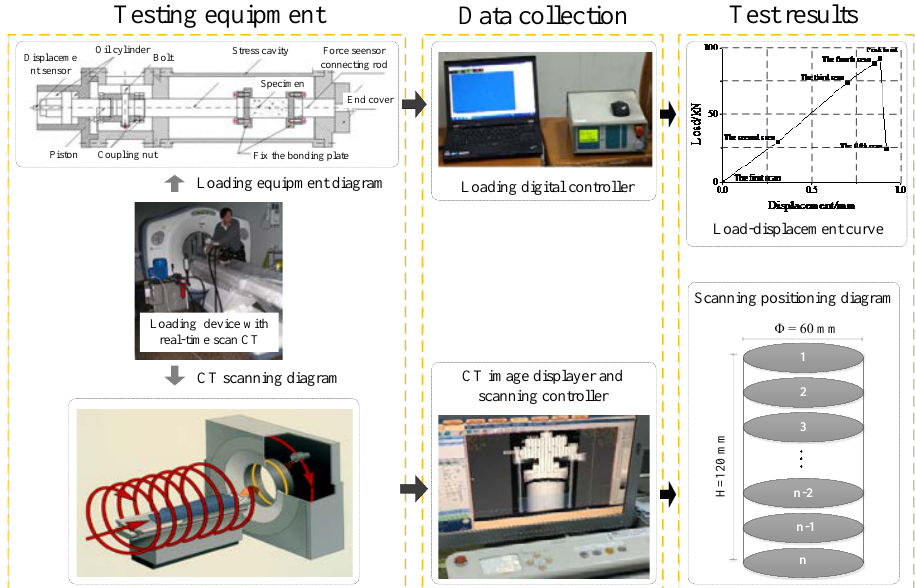
Figure 1. Portable loading device and